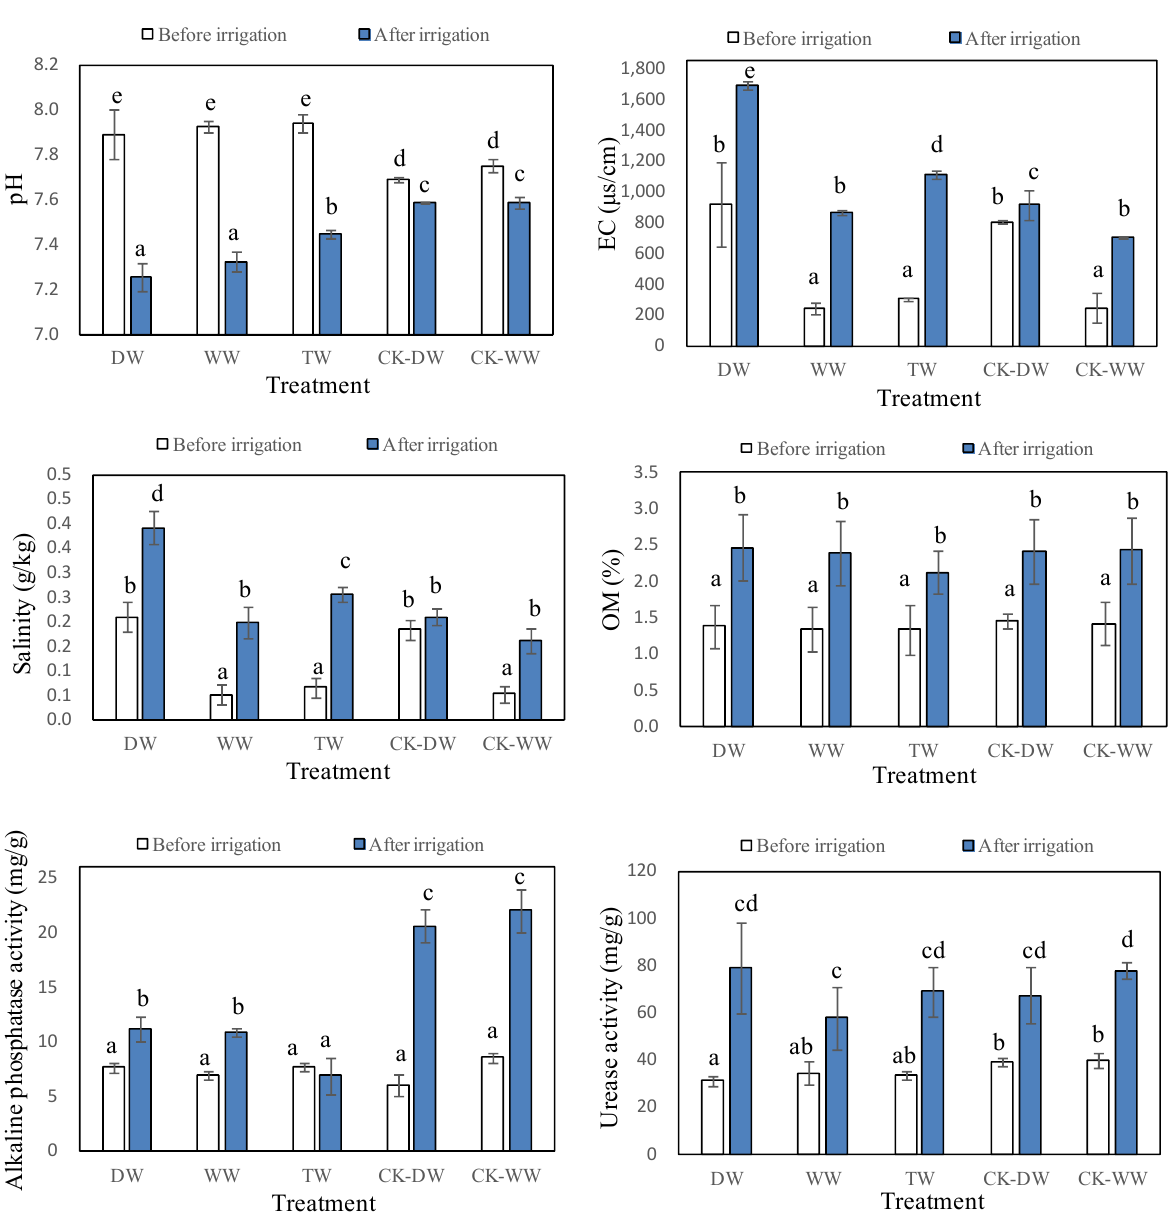
Figure 2. Properties of soil before and after irrigation of the third season planting. Abbreviations: DW, treatment irrigated with tap water and plant; WW, treatment irrigated with wastewater and plant; TW, treatment irrigated with treated wastewater and plant; CK-DW, treatment with no plant and irrigated with tap water; CK-WW, treatment with no plant and irrigated with wastewater. The standard deviation of the mean ( n = 3) is shown; different letters demonstrate a significant difference at p < 0.05 based on ANOVA test